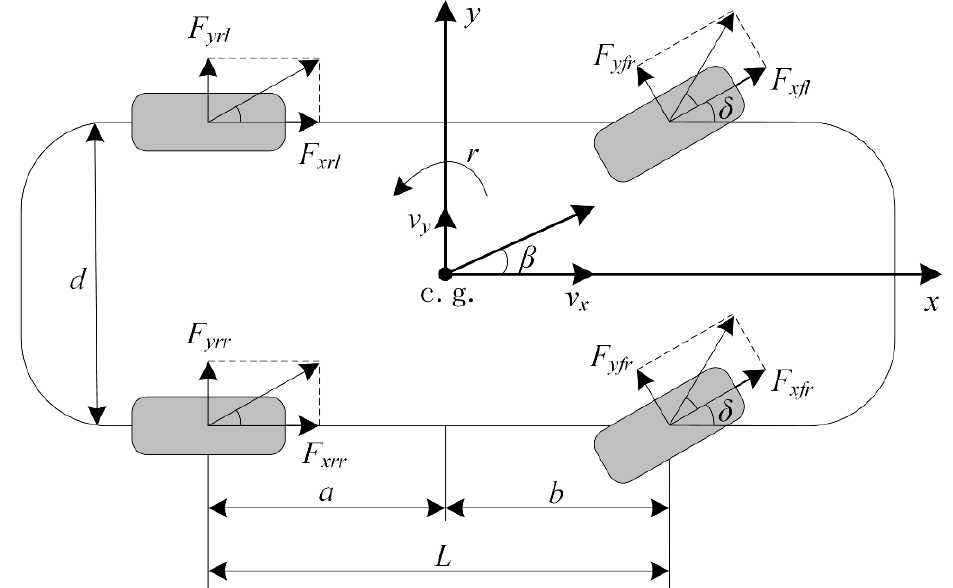
Figure 2. The 7-DOF distributed drive electric bus model.